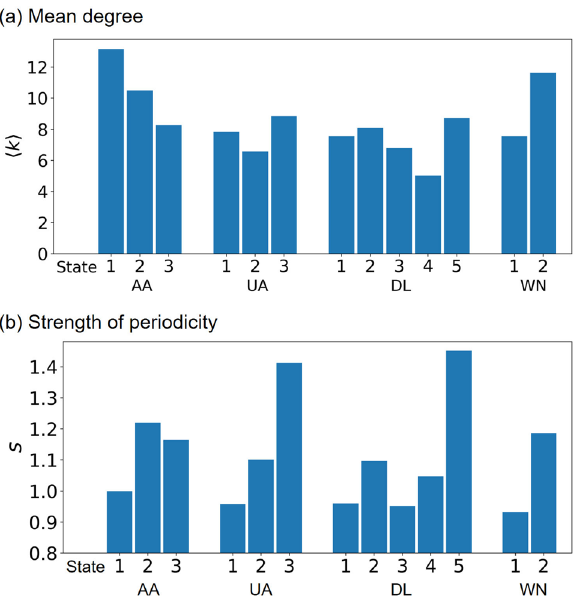
Figure 9. Mean degree and strength of periodicity in each